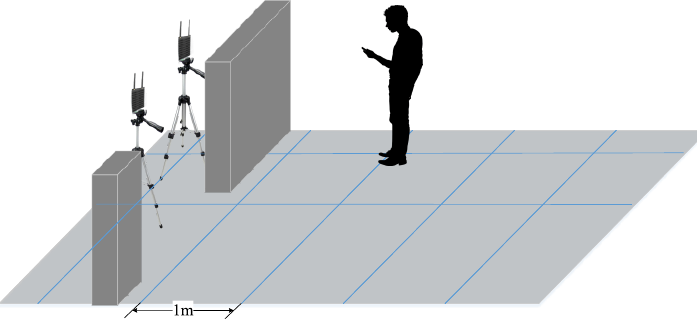
Figure 5. Experiment for estimating the accuracy of the ranging results.